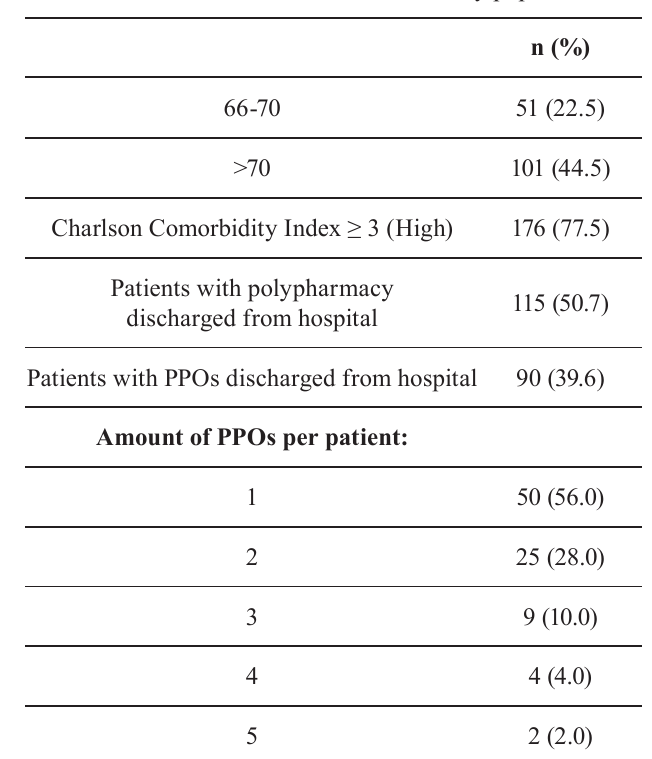
TABLE I – C linical characteristics of the study